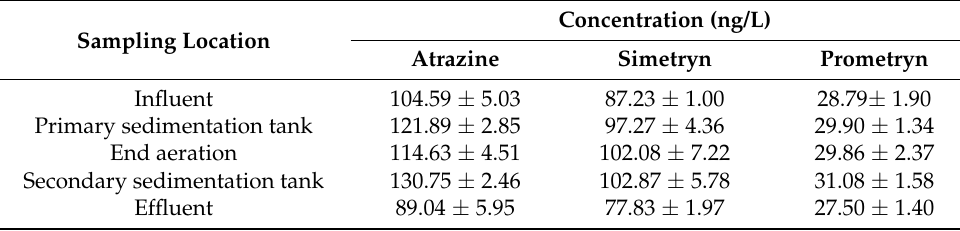
Table 2. The detected concentrations of the triazine herbicides in different